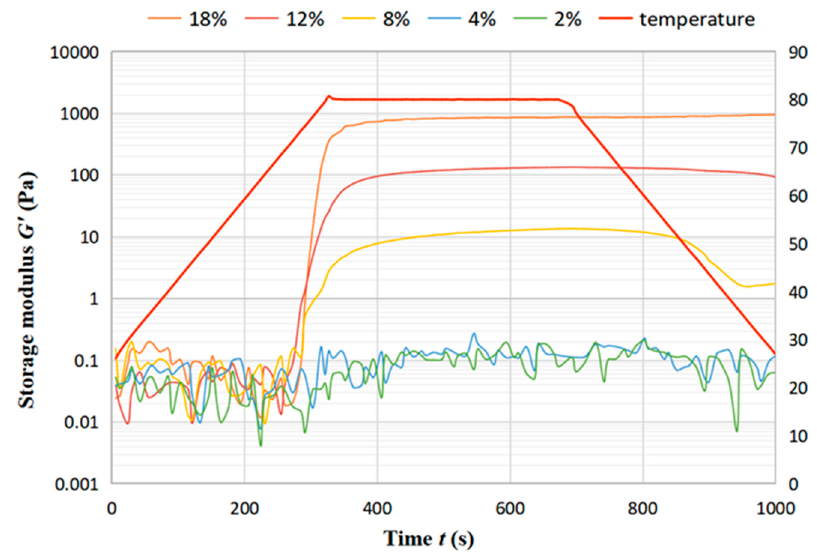
Figure 7. Trend of storage modulus G ′ of DCF dispersion at di ff erent concentration with time.